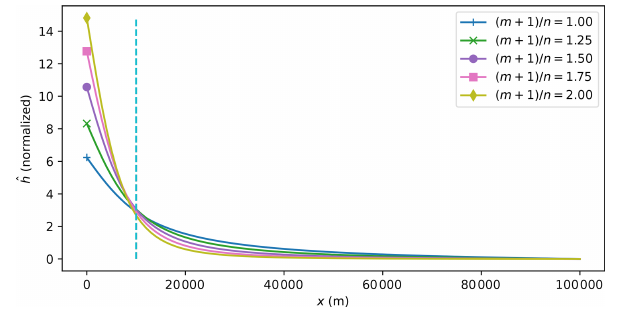
Figure 4. Steady-state depositional profiles of open systems ob- tained by varying the ratio ( m + 1) /n . All other parameters have the same value as in Fig. 2. The profile elevations have been scaled so that they have the same